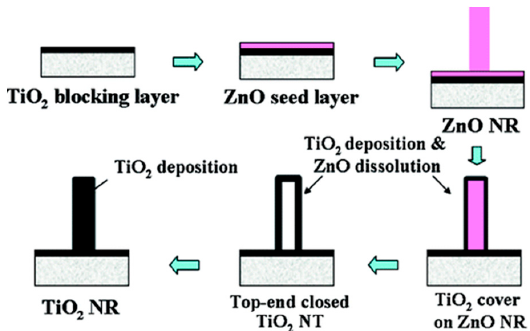
Figure 8. Schematic diagram of formation of TiO 2 NT arrays by ZnO NR template-assisted method. Reprinted with permission from [35]. Copyright 2010 American Chemical Society.